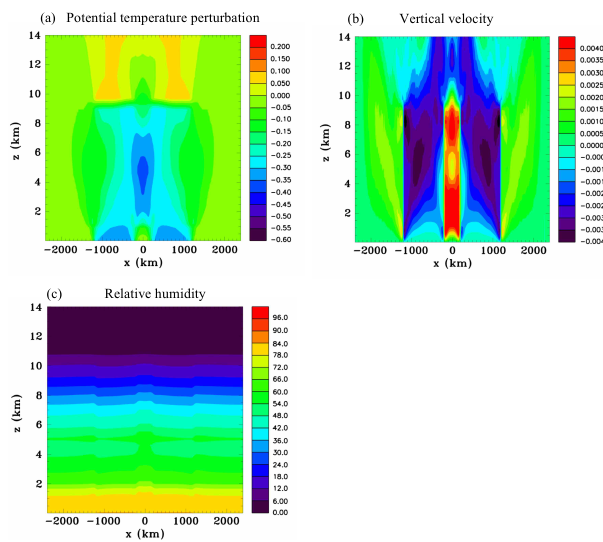
Figure 5. Vertical sections for Experiment 5: the large annulus case, at t = 5h. (a) Potential temperature perturbation (K), (b) vertical velocity (ms − 1 ), and (c) relative